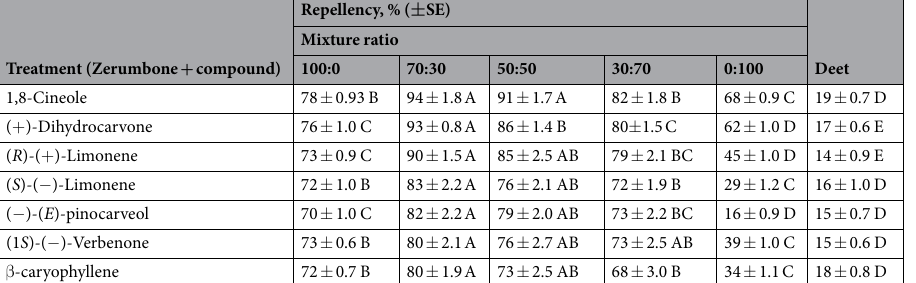
Table 4. Residual repellency of binary mixtures of zerumbone and seven active compounds against male Blattella germanica using a filter-paper choice box assay at 81.5 μ g cm − 2 for 24 h. Means within a row followed by the same letter are not significantly different ( P = 0.05, Bonferroni method).